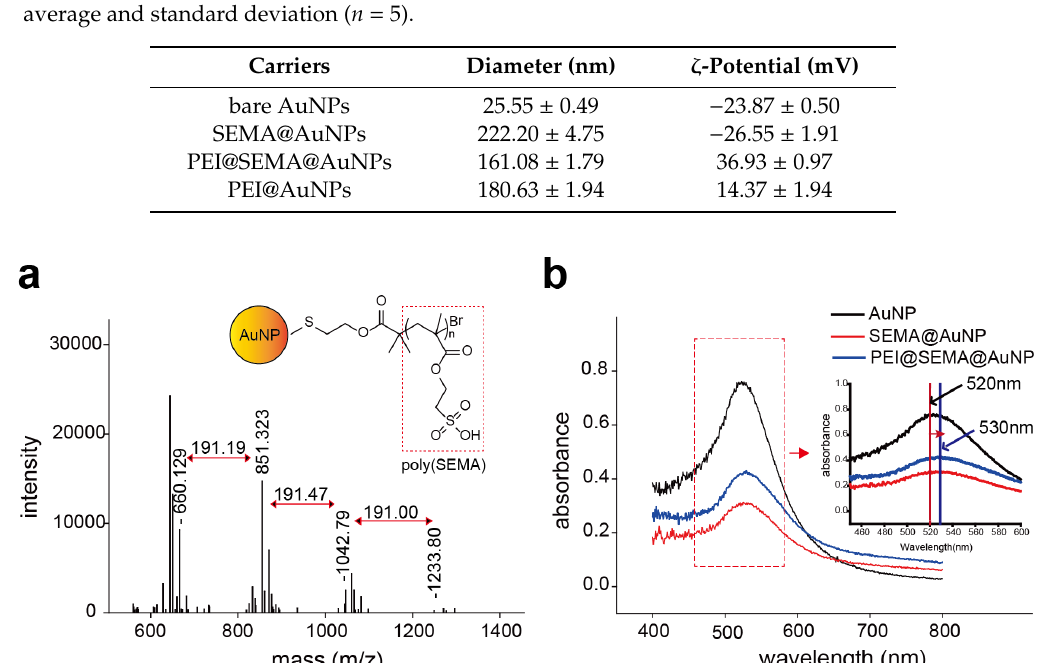
Figure 2. Characterization of surface-decorated AuNPs. ( a ) Quantification of immobilized pSEMA on the surface of particles by using MALDI-TOF / MS. ( b ) Absorbance of AuNPs and SEMA@AuNPs, absorbance of AuNPs had a red shift after modification with 10 nm wavelength. The inset shows a detail of the red shift with 520 nm (bare AuNP) to 530 nm (SEMA@AuNP).